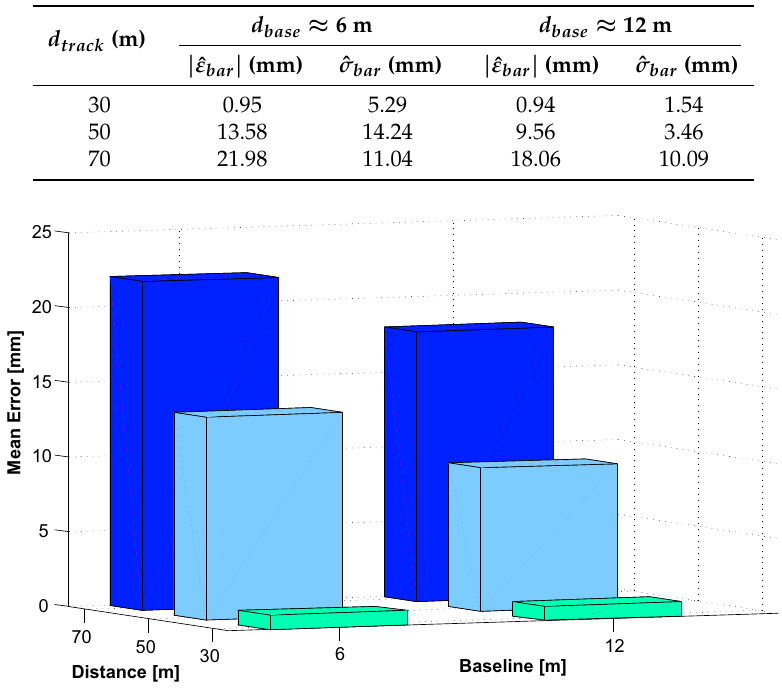
Figure 28. | ˆ ε bar | for all d base and d track .